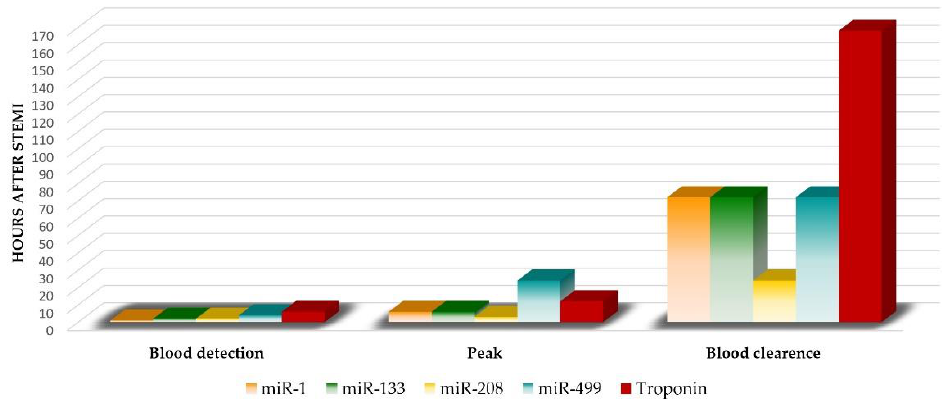
Figure 3. Comparative kinetics of circulant miRNA and troponin in STEMI.